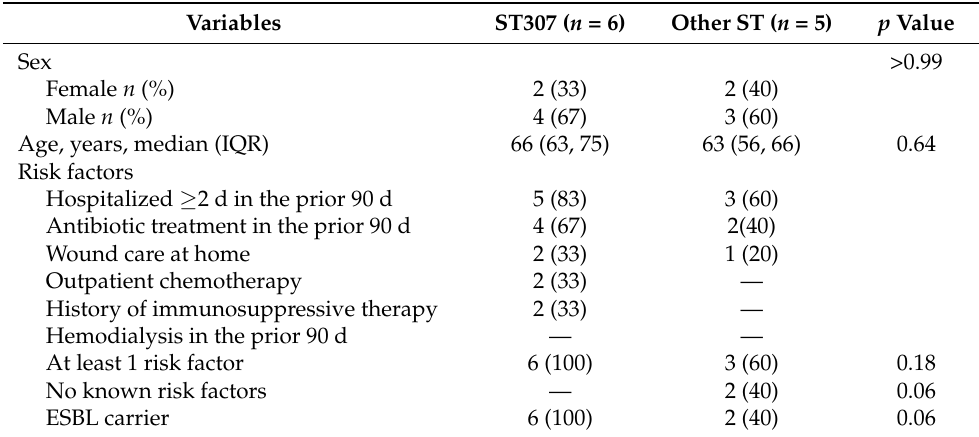
Table 4. Risk factors identified in Klebsiella pneumoniae